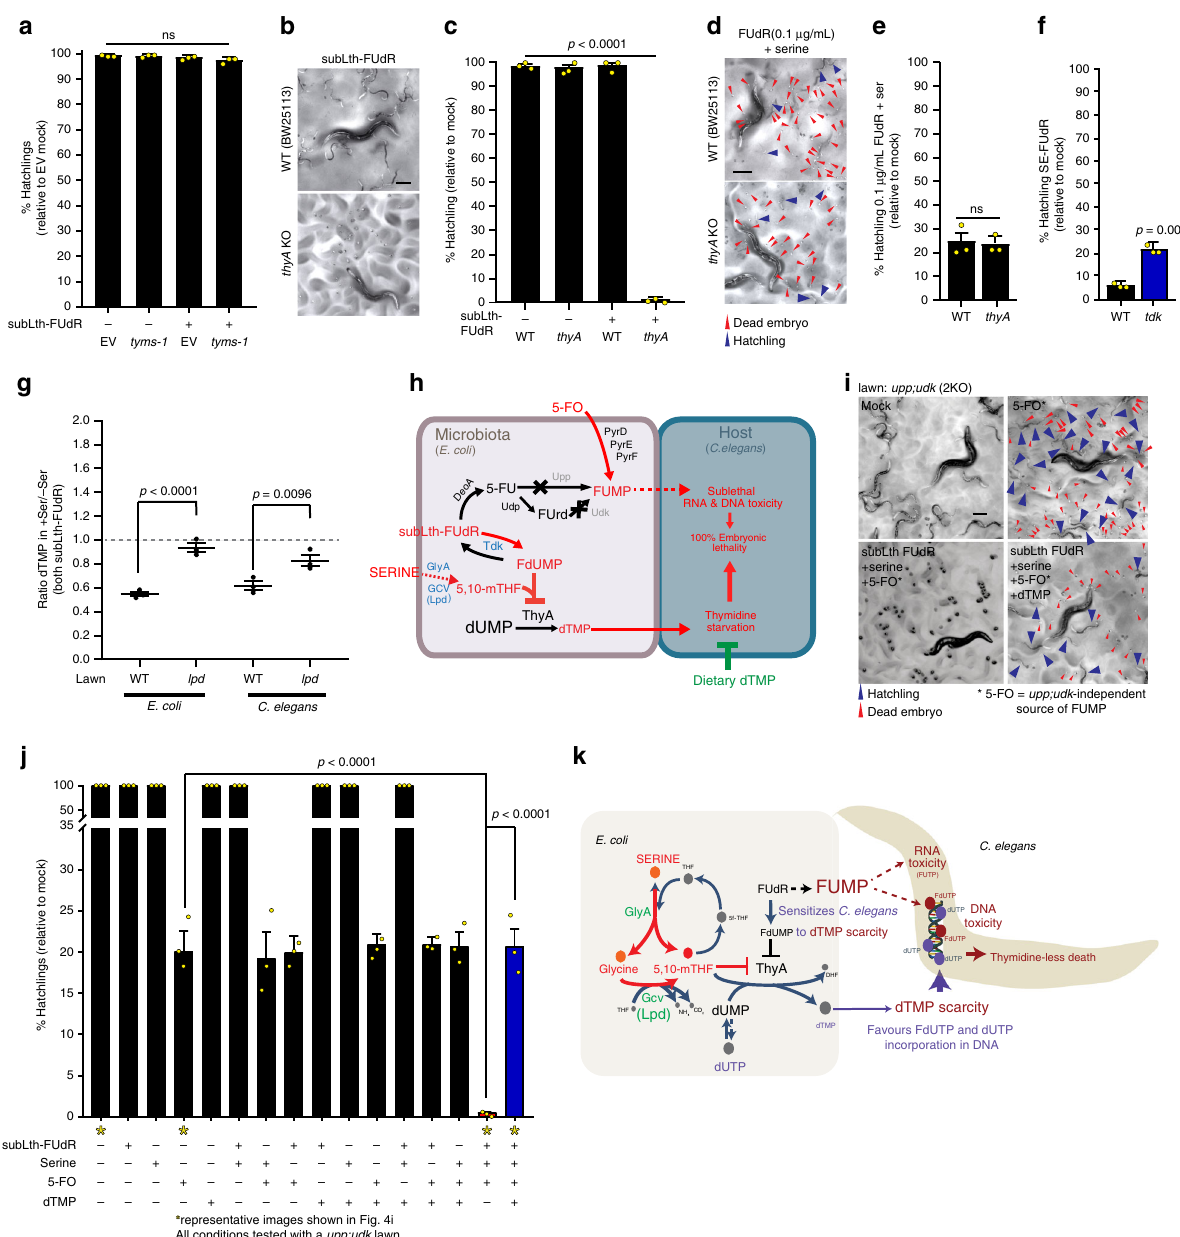
Fig. 4 SE-FUdR promotes dTMP depletion in E. coli and C. elegans . Throughout this fi gure: % hatchlings and LC – MS data were analyzed as described in Fig. 1. Statistical signi fi cance was assessed via two-tailed unpaired nonparametric t -test for % hatchlings quanti fi cation. LC – MS data were analyzed using one-tailed ratio t -test after ROUT outlier treatment. Data are presented as mean values ± SEM, scale bars = 200 µ m. n = # independent biological replicates. Source data are provided as a Source Data fi le. a Quanti fi cation of progeny viability of C. elegans exposed to subLth-FUdR (1 μ g/mL) while cultured on EORB1 (RNAi-competent derivative of HB101) carrying empty RNAi empty vector (EV) or RNAi against tyms-1 . n = 3. See EORB1 strain development in Methods and Supplementary Fig. 8. b Representative images of progeny viability of C. elegans exposed to subLth-FUdR (0.25 μ g/mL) while cultured on WT (BW25113) or thyA KO E. coli lawns. c Quanti fi cation of b treatments. n = 3. d Representative images of progeny viability of C. elegans exposed to subLth-FUdR (0.1 μ g/mL) + serine 1.5 mg/mL while cultured on WT (BW25113) or thyA KO E. coli lawns. e Quanti fi cation of d treatments. n = 3. f Quanti fi cation of progeny viability of C. elegans exposed to subLth-FUdR ± serine while cultured on WT (BW25113) or tdk KO E. coli lawns. n = 3. g LC – MS measurement of dTMP normalized to [ 13 C9, 15 N2]UMP (Norm dTMP) in E. coli WT (BW25113) and lpd KO, and C. elegans cultured in these two E. coli strains. The ratio Norm dTMP in SE-FUdR / Norm dTMP in subLth-FUdR is depicted for each treatment. n = 3. h Setup of dTMP-rescue experiment: (1) upp;udk double KO lawn avoids enhanced-FUMP toxicity otherwise driven by thymidine; (2) 5 ′ - fl uoroorotic acid (5-FO) as a source of FUMP; (3) subLth- FUdR + serine to promote SE-FUdR; (4) ±dTMP to test rescue of SE-FUdR toxicity. i Representative images of progeny viability of C. elegans cultured on upp;udk double KO E. coli lawns ±5-FO, ±SE-FUdR (0.25 μ g/mL FUdR and 1.5 mg/mL serine), ±dTMP (1.5 μ g/mL) showing dTMP rescues SE-FUdR toxicity. j Quanti fi cation of treatments in i (denoted with asterisks) and other controls. n = 3. k Working model of SE-FUdR toxicity. Through promoting 5,10-mTHF synthesis, dietary serine enables FdUMP-mediated inhibition of E. coli TS (ThyA). The consequent scarcity of dietary dTMP then exacerbates the toxic effect of sublethal FUdR, leading to DNA toxicity, and death of the